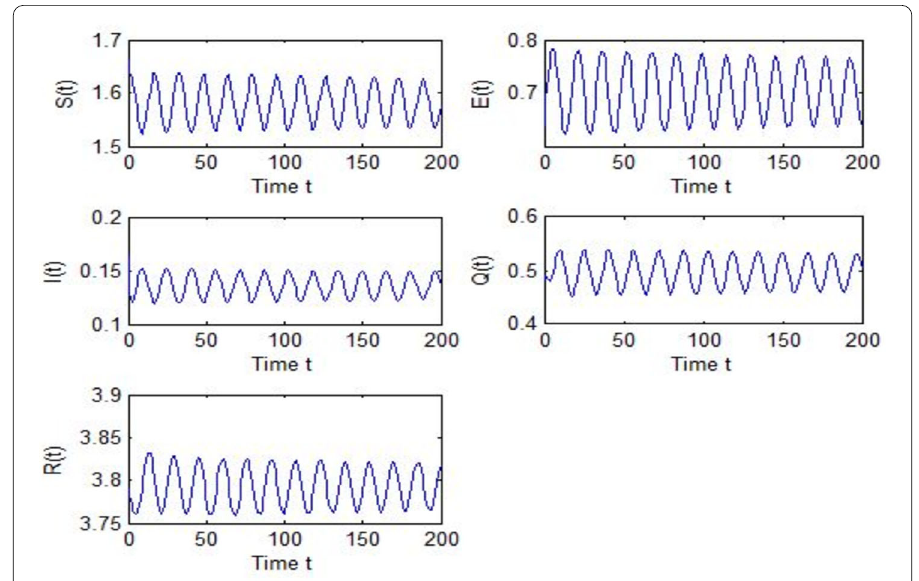
Figure 6 Evolutions of S , E , I , Q , R for τ ∗ = 3.1951 > τ ∗ 0 along with time t